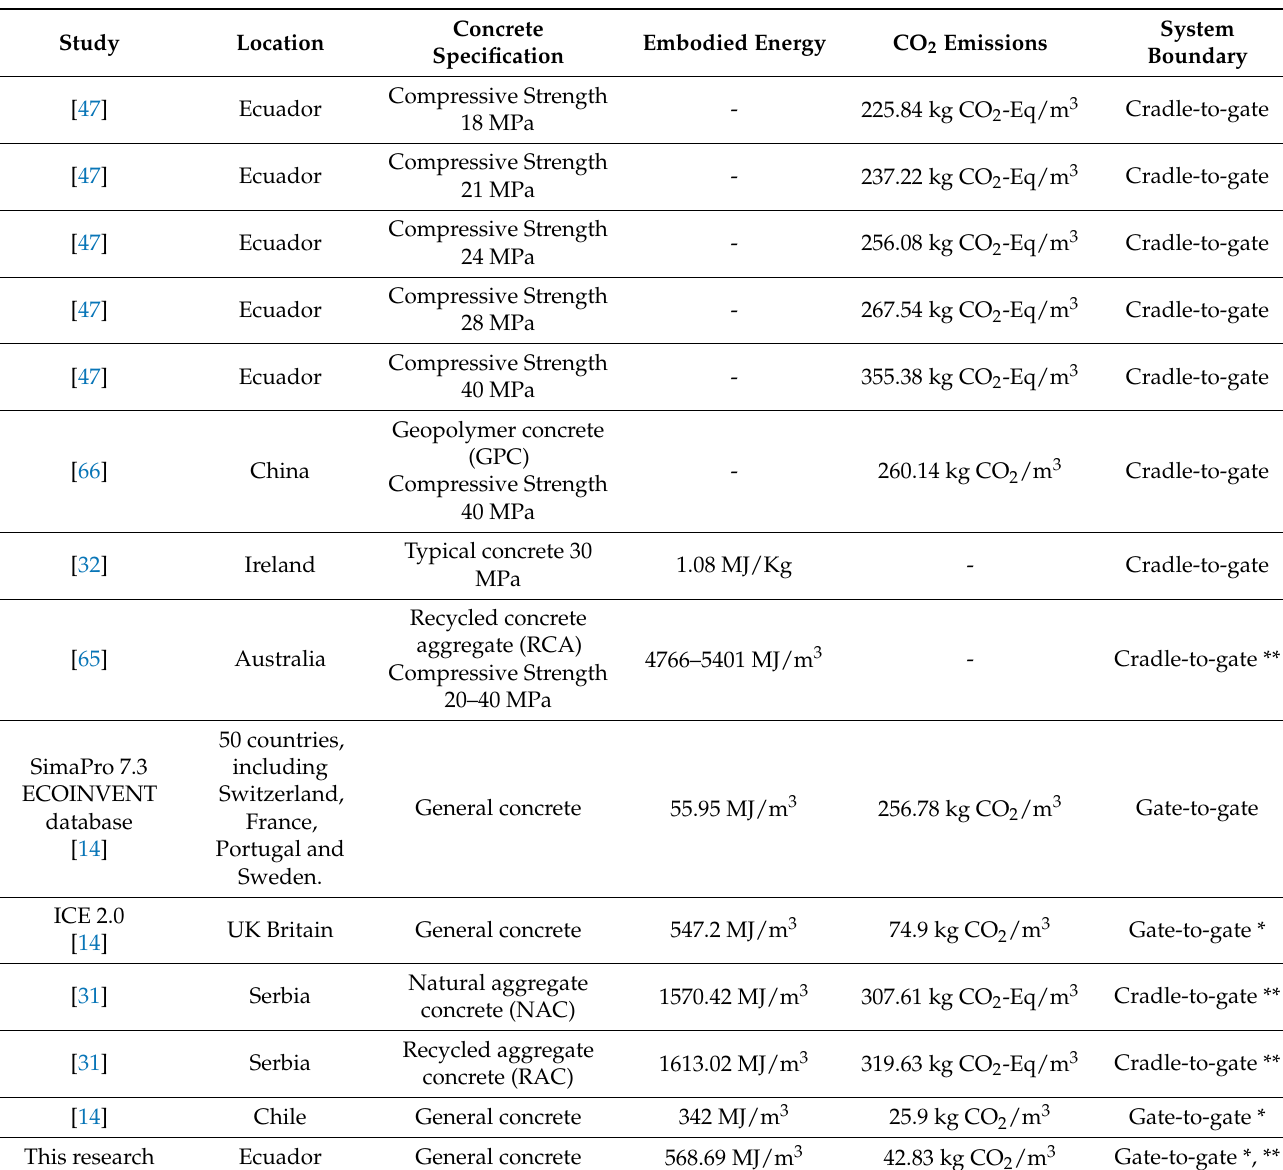
Table 2. Comparison of embodied energy and CO 2 emissions in concrete production between different studies and databases.